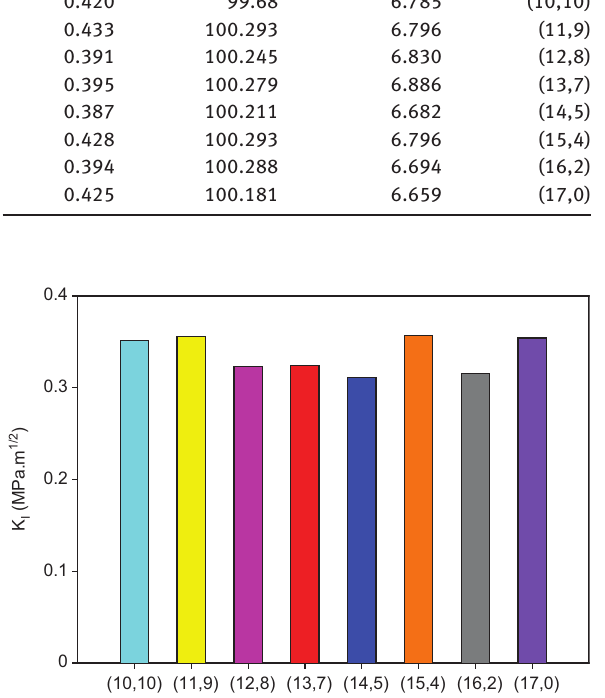
Figure 3 Stress intensity factor of RVEs having CNTs possessing similar radius and length.